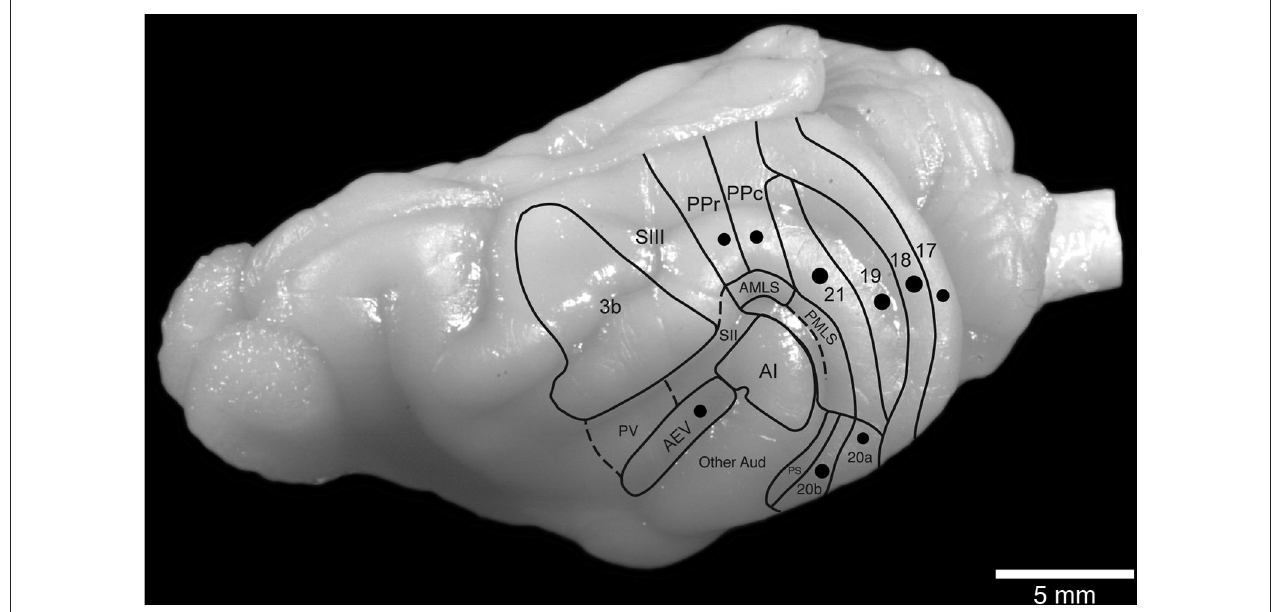
FIGURE 1 | Location and approximate size of the injection sites analyzed in the current study in relation to the known boundaries of visual cortical areas in the ferret brain.